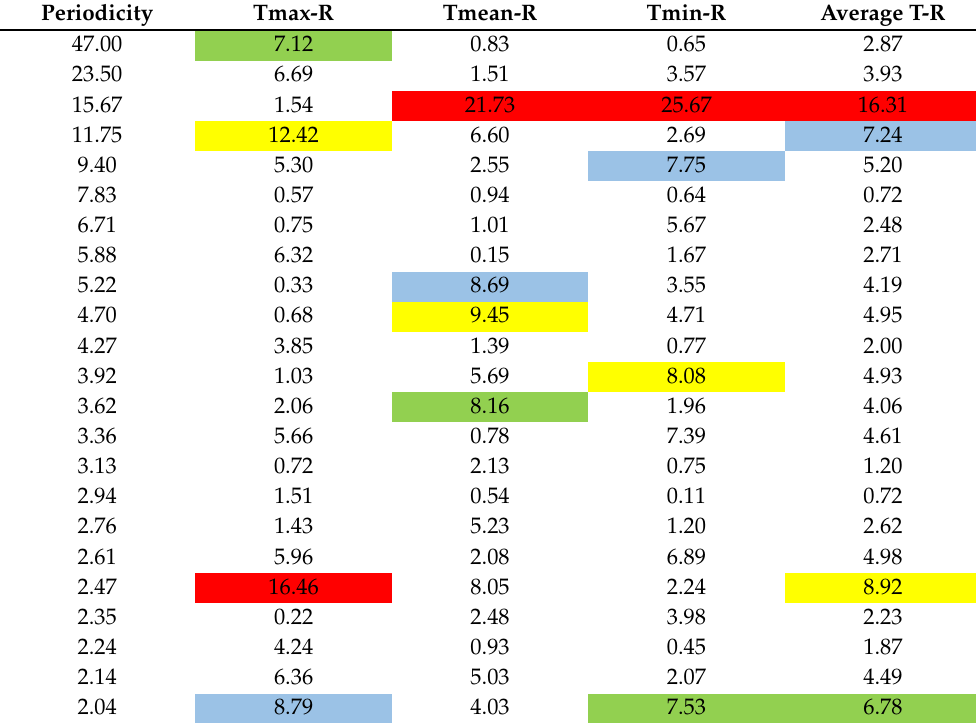
Table 8. Significant periods for the temperature series corrected for